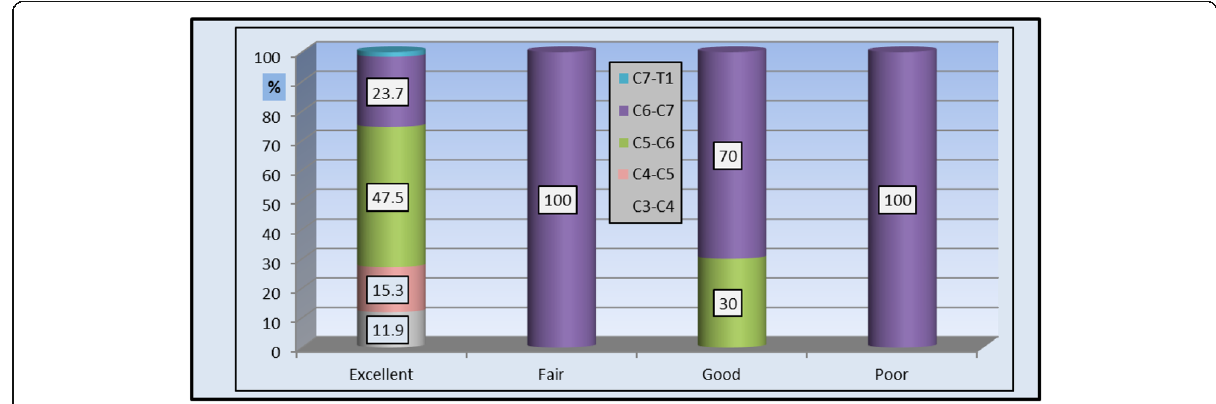
Fig. 5 Odom ’ s category in relation to disc